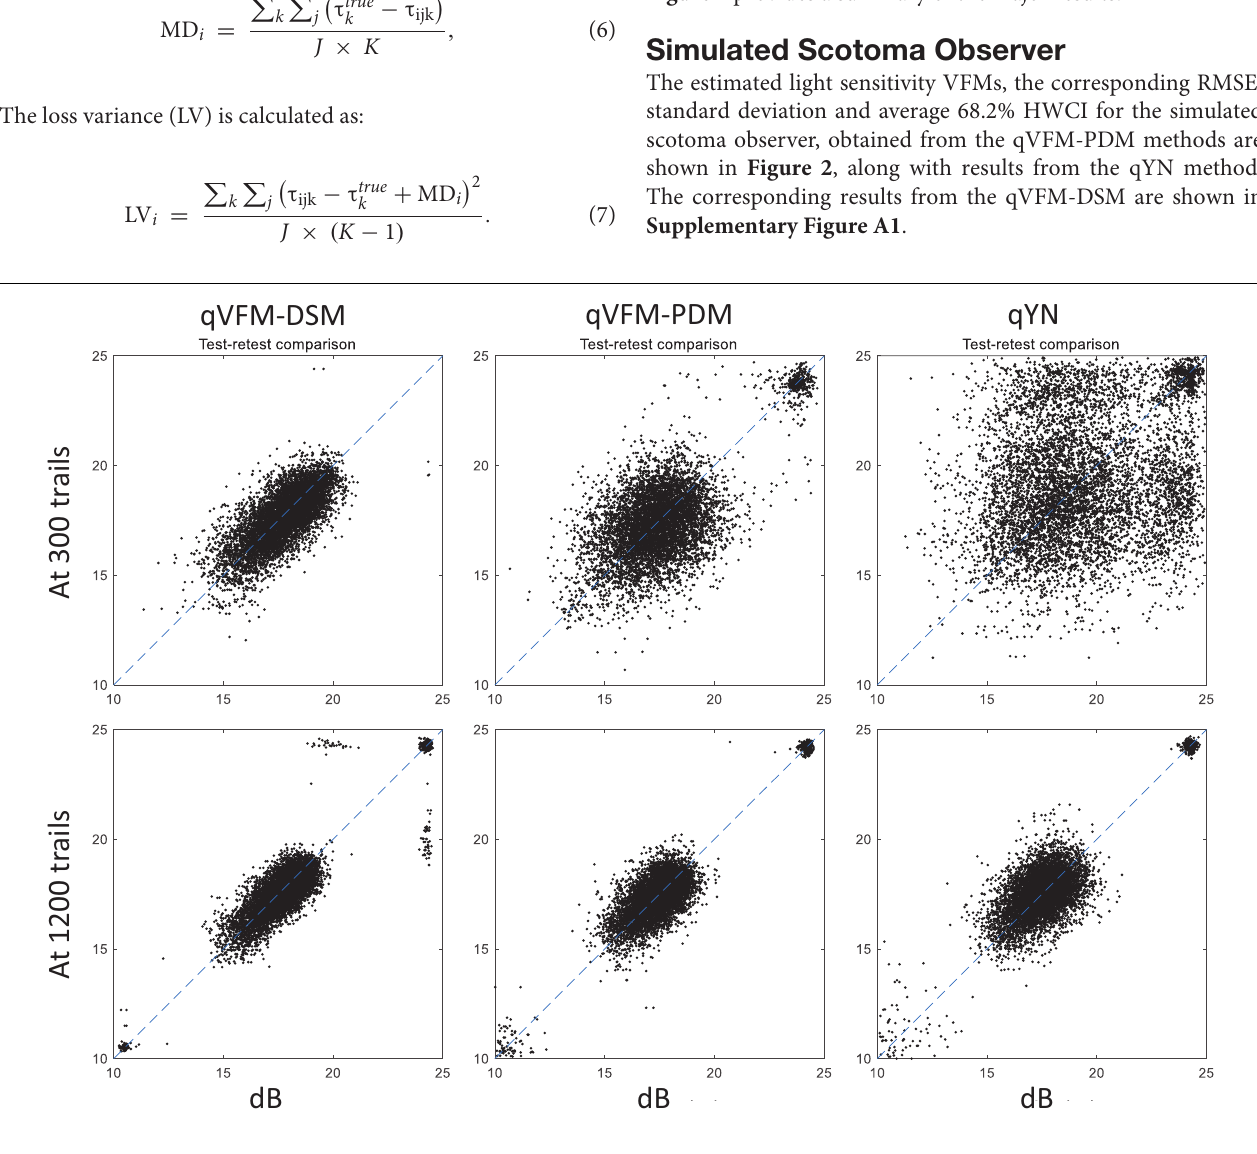
Frontiers in Neuroscience |